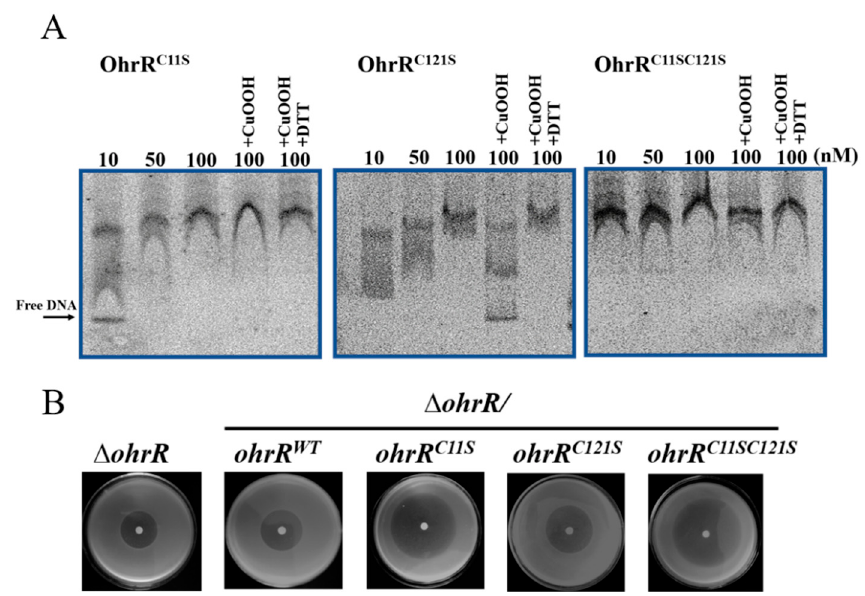
Figure 5. Effect of OhrR cysteine mutations on peroxide sensing in vitro and in vivo. ( A ) EMSA. DNA fragment covering the promoter region of ohr was incubated with the given concentration of purified OhrR C11S , OhrR C121S , OhrR C11SC121S proteins. 0.1 mM CuOOH or 0.1 mM CuOOH plus 0.5 mM DTT were added to the mixtures. ( B ) Disc diffusion assay. Paper discs of 6 mm in diameter loading with 4 µL 4.88 M CuOOH were placed on bacterial lawns. The inhibition zones were observed around the disks after incubated at 28 °C for 48 h.